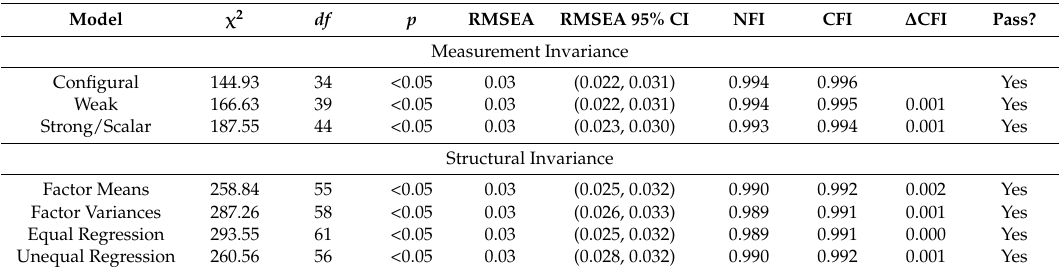
Table 3. Fit Indices for Multigroup Invariance Comparisons based on YOC Status—Measurement model 4 and SEM model 5.